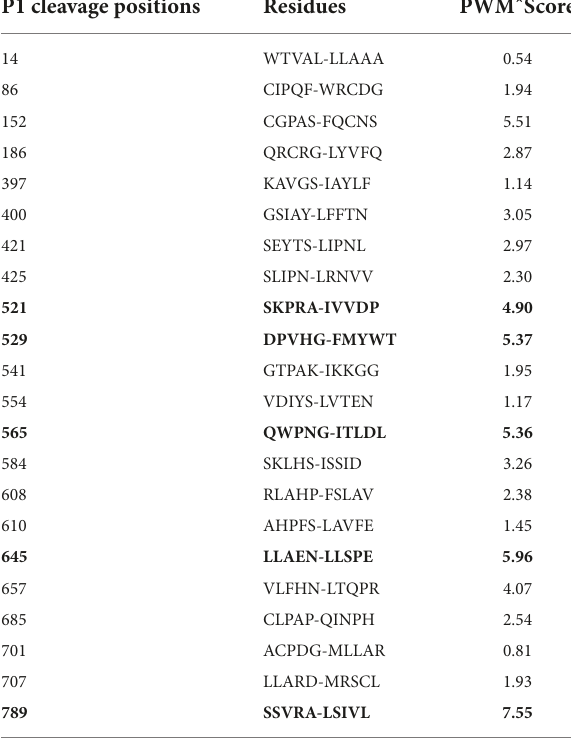
TABLE 2 Predicted MT1-MMP cleavage site on LDLR as determined by the online CleavePredict software, showing cleavage positions, residues and position weight matrix